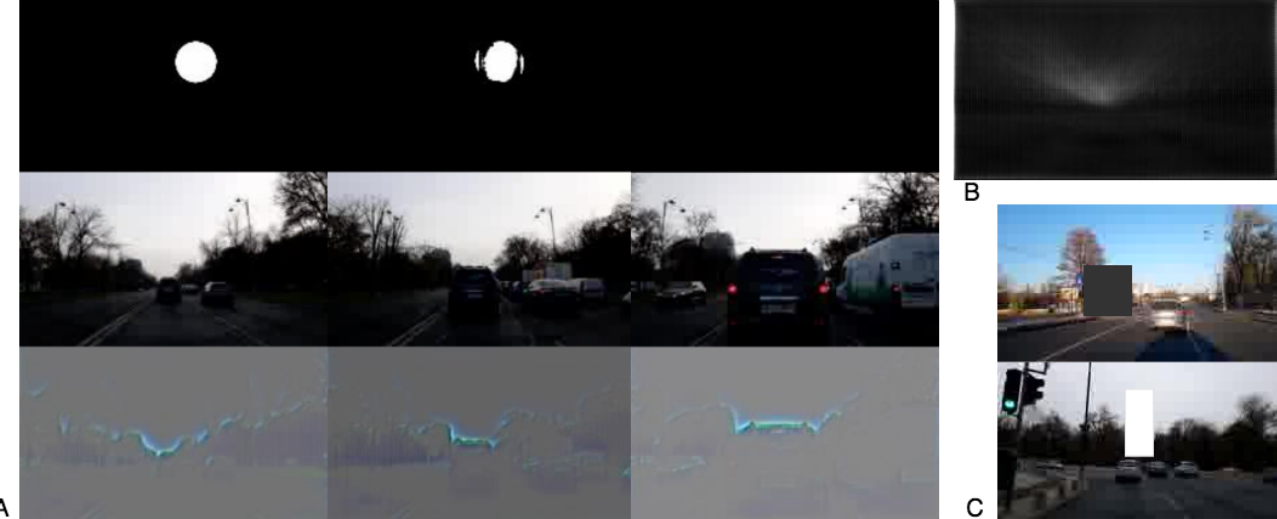
Figure 5. Analyzing the network’s attention by applying the guided backpropagation technique. ( A ) The top row shows the prediction of the network for the observer’s location, while the bottom one shows the visual cues of most interest for the network. It can be seen that as the camera approaches the SUV vehicle, the skyline shape changes and the segmentation of the dot fades away. ( B ) The guided backpropagation mean pixel activation values over the training set images. ( C ) Augmented images (with occlusions being added in the form of rectangles of constant grey level) used for robust